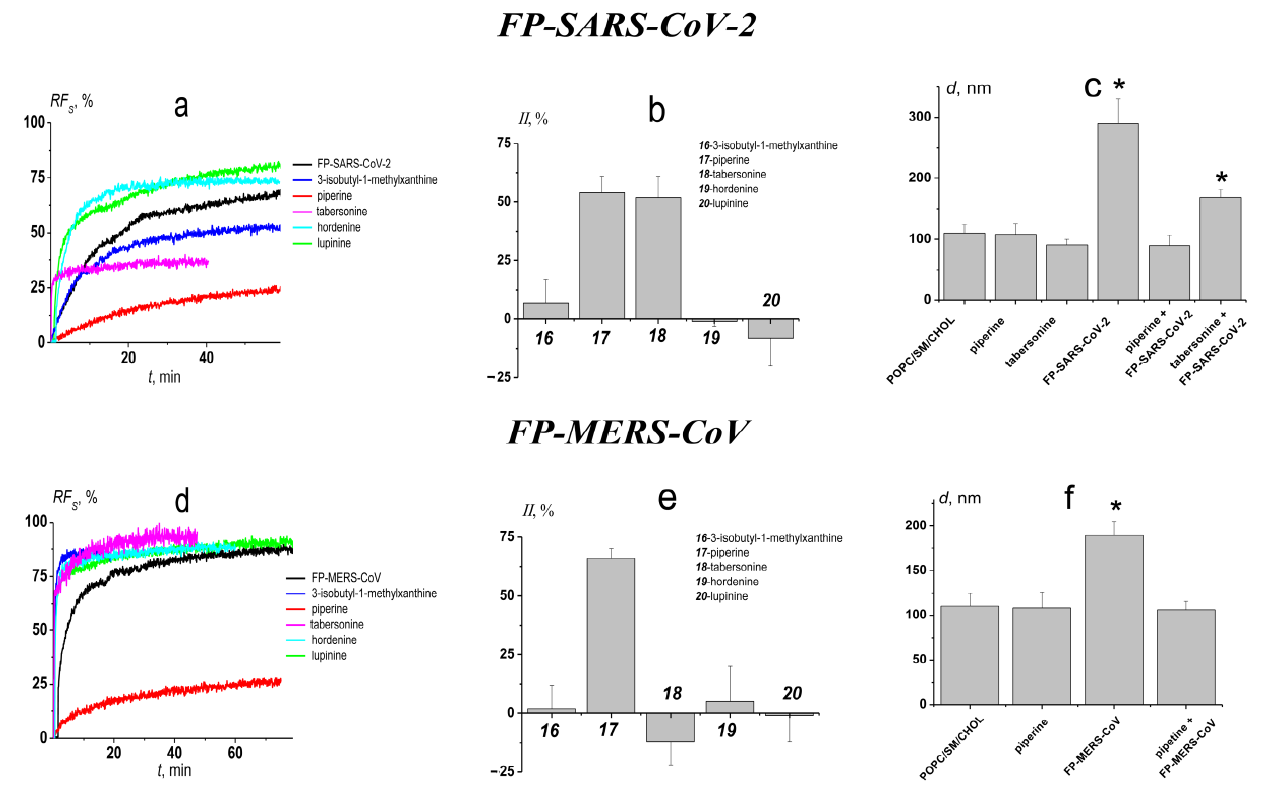
Figure 5. The effects of the alkaloids on FP-SARS-CoV-2 (upper panel) and FP-MERS-CoV (lower panel) mediated fusion of POPC/SM/CHOL (60/20/20 mol%) vesicles. ( a , d ) The time dependence of relative fluorescence of calcein ( RF S , %) leaked due to the fusion induced by 50 µ M of FP-SARS-CoV-2; ( a ) and 200 µ M of FP-MERS-CoV; ( d ) in the absence and presence of alkaloids. Liposomes were incubated with 400 µ M of alkaloids for 30 min before addition of the peptides. The relationship between the color line and the alkaloid is given in the figure. ( b , e ) The inhibition index ( II ) characterizing the ability of tested alkaloids to suppress the fusion induced by 50 µ M of FP-SARS-CoV-2 ( b ); and 200 µ M of FP-MERS-CoV ( e ). ( c , f ) The diameter ( d , nm) of the POPC/SM/CHOL liposomes before and after addition of 50 µ M of FP-SARS-CoV-2 ( c ) and 200 µ M of FP-MERS-CoV ( f ) to vesicles pretreated with 400 µ M of piperine or tabersonine. *— p ≤ 0.01 (Mann–Whitney–Wilcoxon’s test, untreated liposomes vs. vesicles in the presence of fusion peptides or/and alkaloids). Table 3. The parameters characterized the effects of alkaloids on the calcein release caused by the FP-SARS-CoV-2 and FP-MERS-CoV-mediated fusion of liposomes composed of POPC/SM/CHOL. 50 µ M FP-SARS-CoV-2 200 µ M FP-MERS-CoV Alkaloid RF S , % t 1 , min t 2 , min RF S , % t 1 , min t 2 , min inducer 77 ± 6 11 ± 1 3-isobutyl-1-methylxanthine 66 ± 5 3 ± 1 * piperine 33 ± 3 * 9 ± 3 tabersonine 53 ± 9 ** 1 ± 1* 27 ± 13 * 79 ± 7 hordenine 74 ± 8 lupinine RF S —the maximum leakage of fluorescent marker caused by the fusion of liposomes composed of POPC/SM/CHOL (60/20/20 mol%) mediated by 50 µ M FP-SARS-CoV-2 or 200 µ M FP-MERS-CoV. Liposomes have been incubated with 400 µ M of alkaloids for 30 min before the addition of CaCl 2 . t 1 and t 2 —the time constants characterizing the fast (1) and slow (2) components of marker release kinetics (the time dependences of marker leakage were fitted by two-exponential functions). *— p ≤ 0.01, **— p ≤ 0.05 (Mann–Whitney–Wilcoxon’s test, fusion peptide alone vs. fusion peptide +